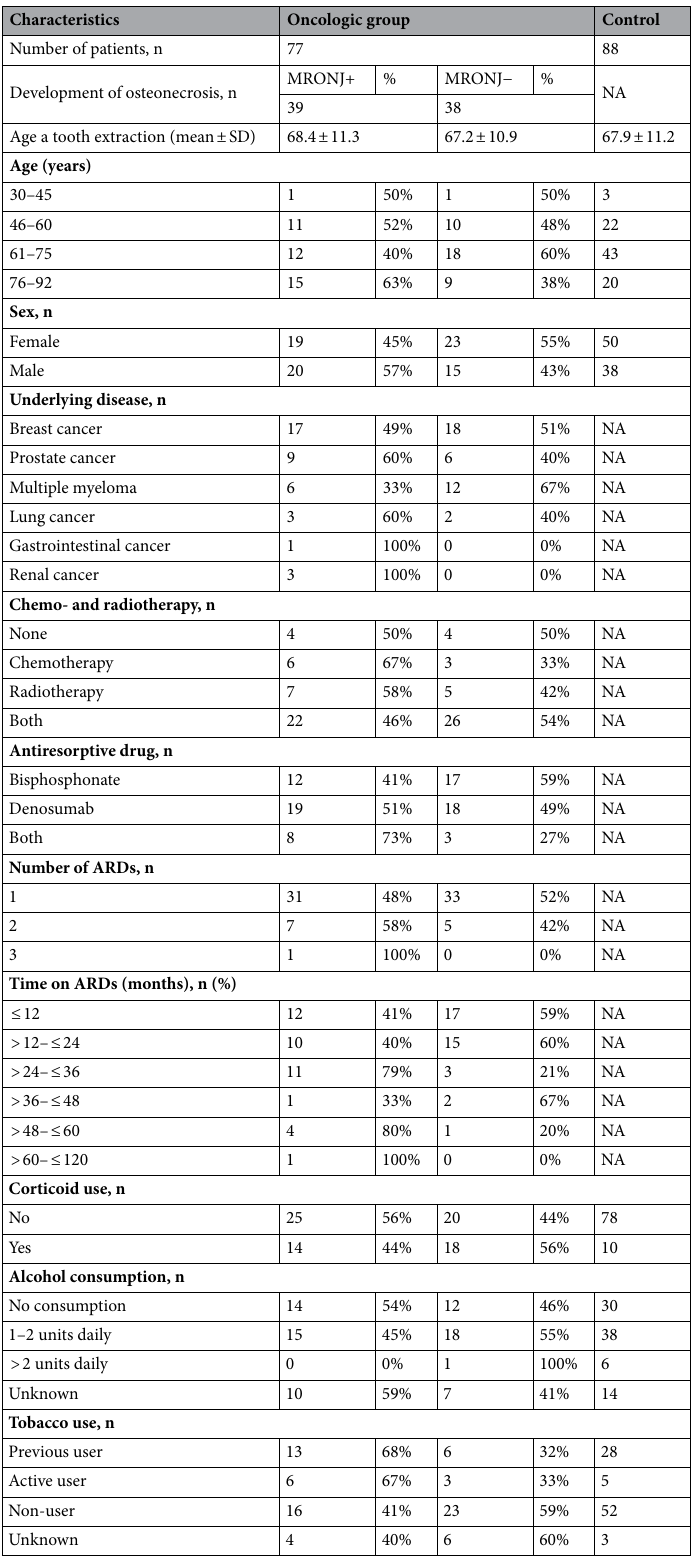
Table 1. Descriptive data from study group and control patients. NA, not